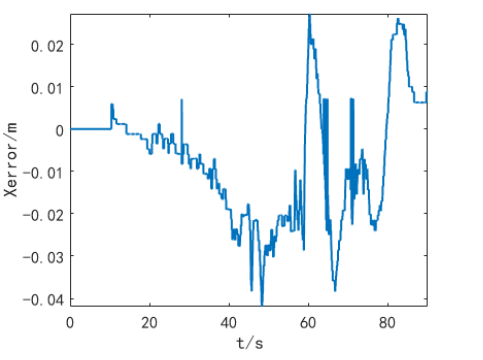
Figure 10. The result of Z-axis. The subscript labels d , r represent the target and the CHSM’s endpoint respectively and have the same meaning in the Figure 11.